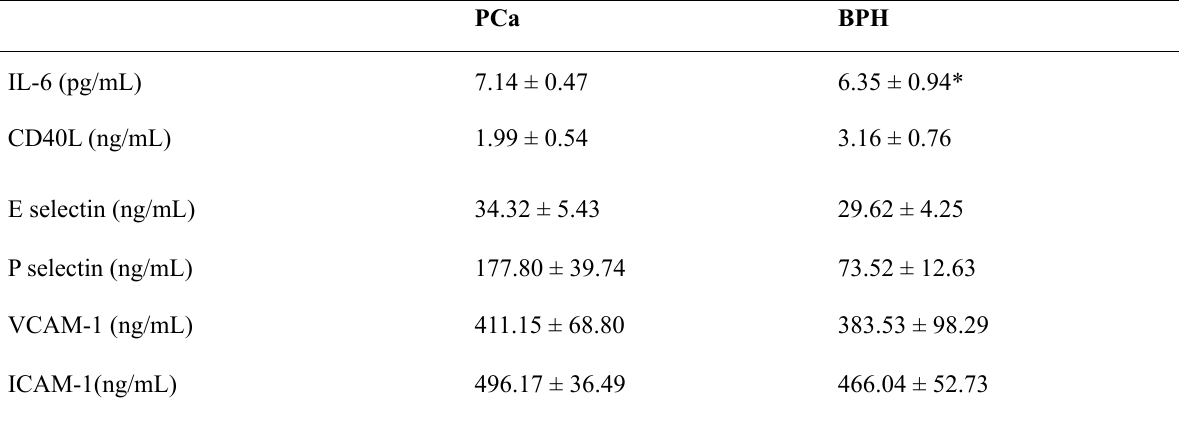
Table 2 - Parameters measured in local blood